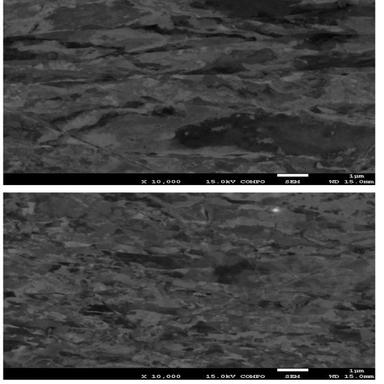
The backscattered FE-SEM channeling-contrast images show the high-angle grain structures of magnesium matrix and nickel foil layers after AFF consolidations from different regions.